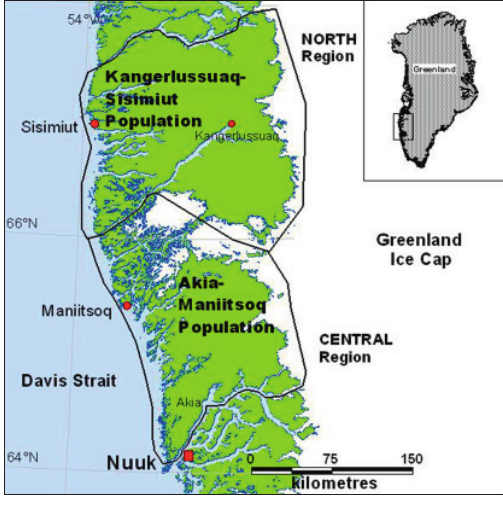
Fig. 1. Regions for the Kangerlussuaq-Sisimiut and Akia-Maniitsoq caribou herds in West Greenland, elevations are not